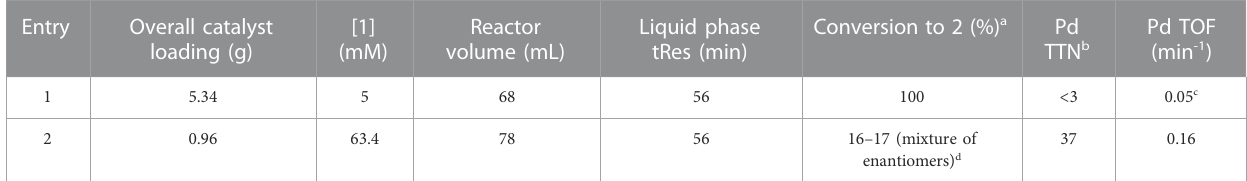
TABLE 5 Continuous hydrogenation of 1 by Pd/C pellets in packed bed